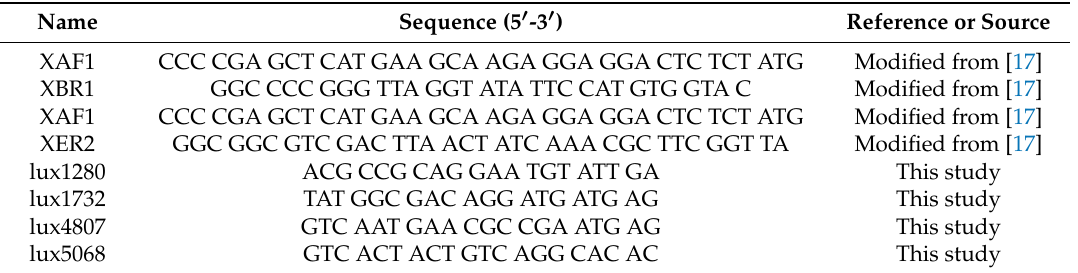
Table 1. Primers used in this study for the Polymerase Chain Reaction (PCR) detection of lux